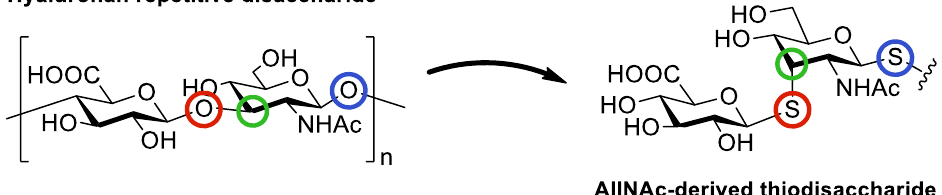
Figure 2. Hyaluronic acid repetitive unit and proposed structural modifications to reach AllNAc- containing thiodisaccharide analogues.